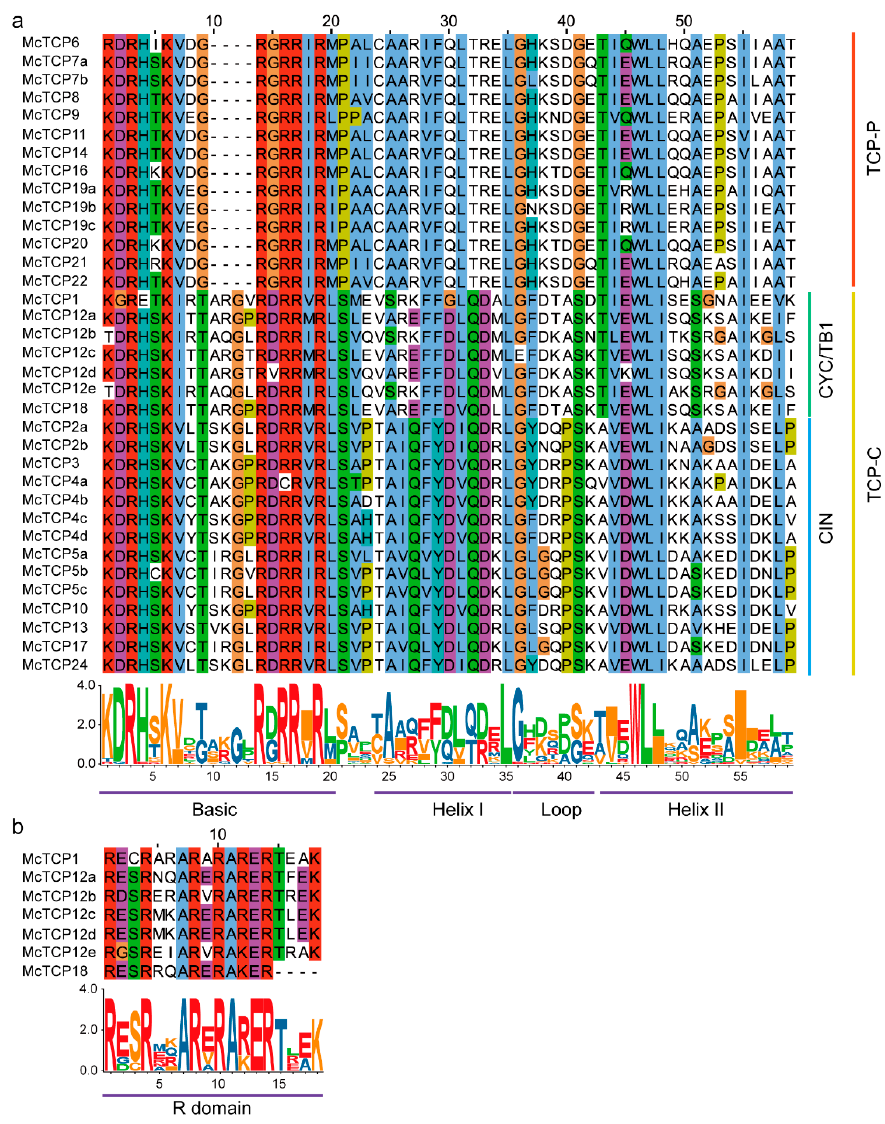
Figure 6. Sequence alignment and seqlogo of TCP TFs. ( a ) Alignment of the TCP superfamily domain in all identified TCP TFs; ( b ) Alignment of the R domain in all identified TCP TFs. The same color in the column and the big size of the letters in the seqlogo graph denote a high level of conservation in the corresponding position.